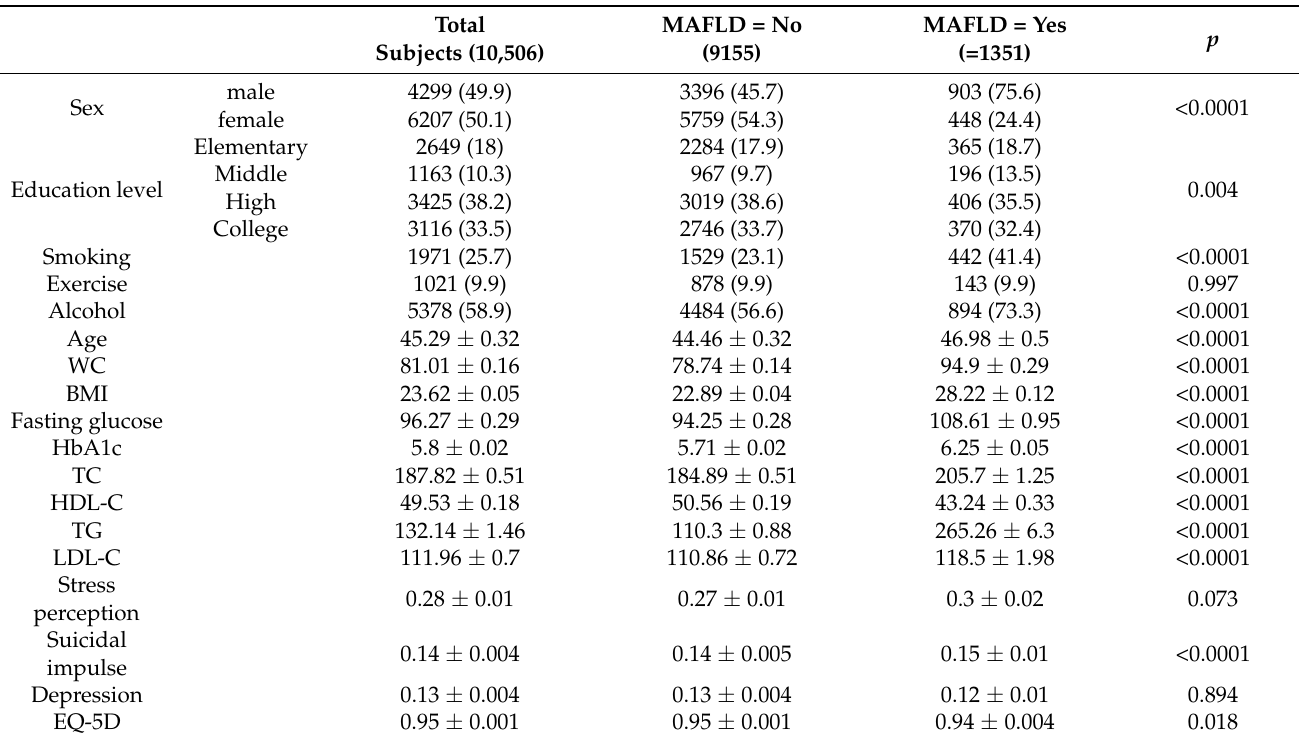
Table 1. Differences between general characteristics and mental health, stress, HRQoL, and MAFLD.